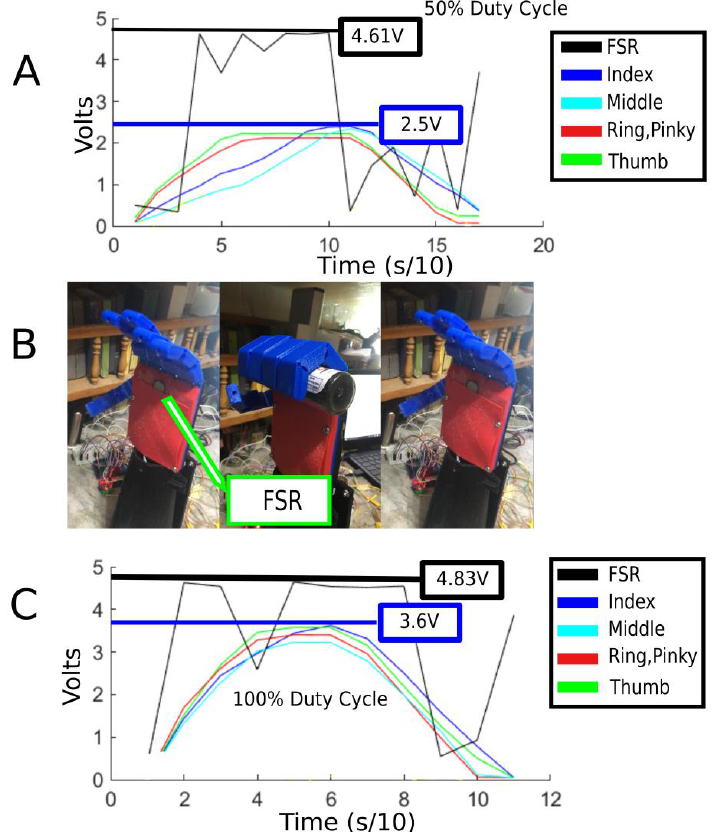
Figure 4. Details of the FSR experimentation. ( A ) Graph showing the FSR readings along with the finger position signal vs. time, using 50% duty cycle for the finger actuators. ( B ) Image showing the placement of the FSR in the palm (left) and the hand when it is fully closed and grasping an object. ( C ) Graph showing the FSR readings along with the finger position signal vs. time, using 100% duty cycle for the finger actuators.